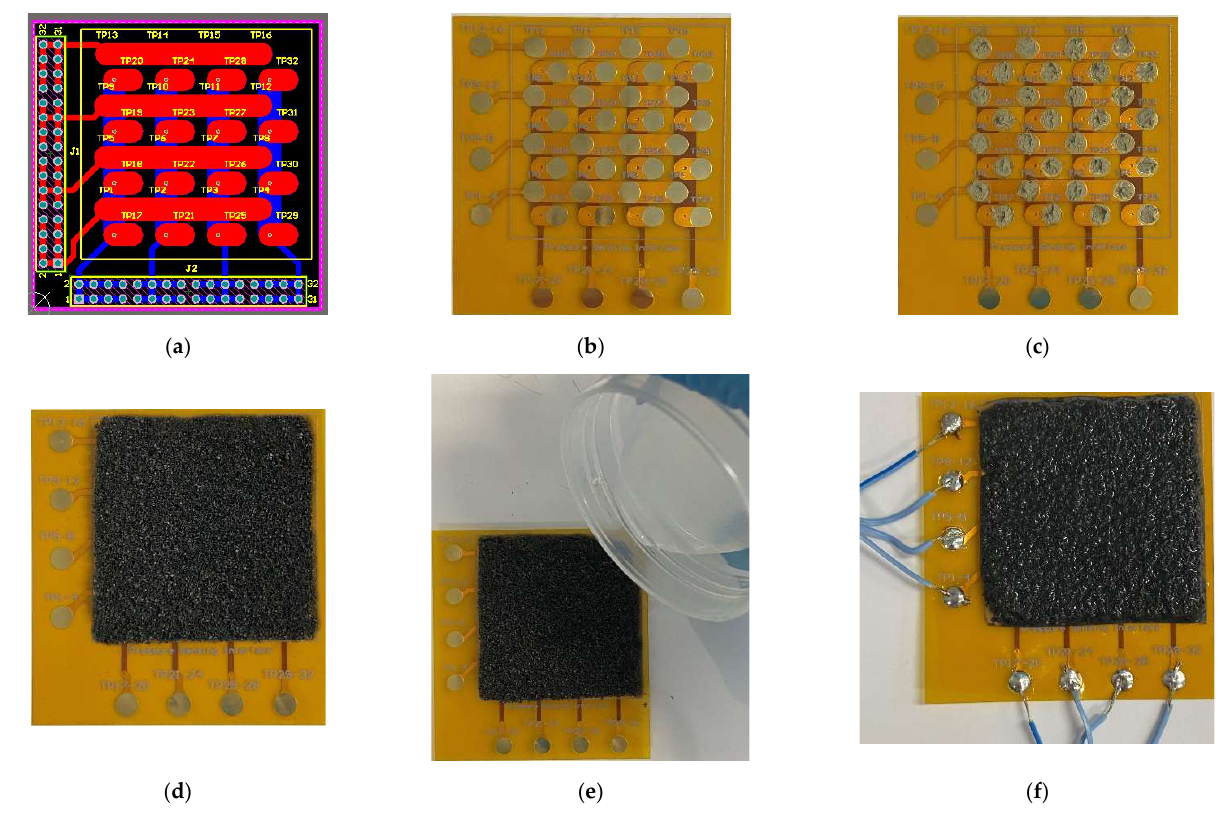
Figure 3. Fabrication process flow of the tactile pressure sensor with an FPCB and rGO film ( a ) double-layer PCB CAD design, ( b ) FPCB for 4 × 4 sensels, ( c ) FPCB with conductive silver grease applied, ( d ) rGO film attached to FPCB, ( e ) pouring of Ecoflex 00-30 onto the rGO film, ( f ) a completed tactile sensor [32].